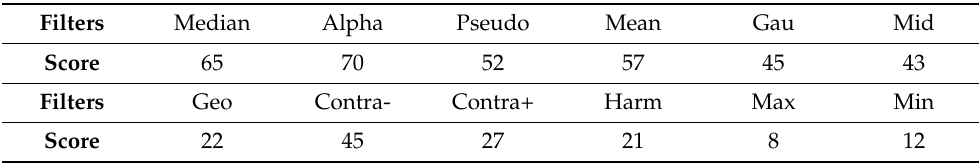
Table 8. Total Scores of Spatial and Adaptive Filters for Impulsive